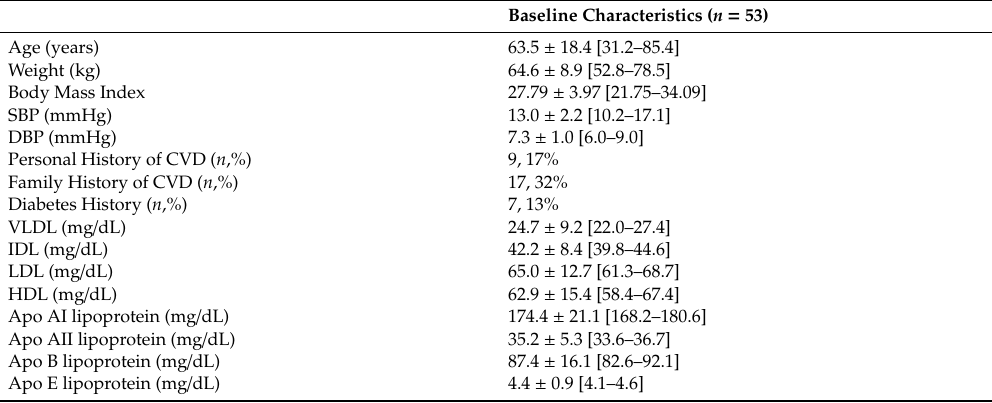
Table 1. Baseline characteristics of the studied